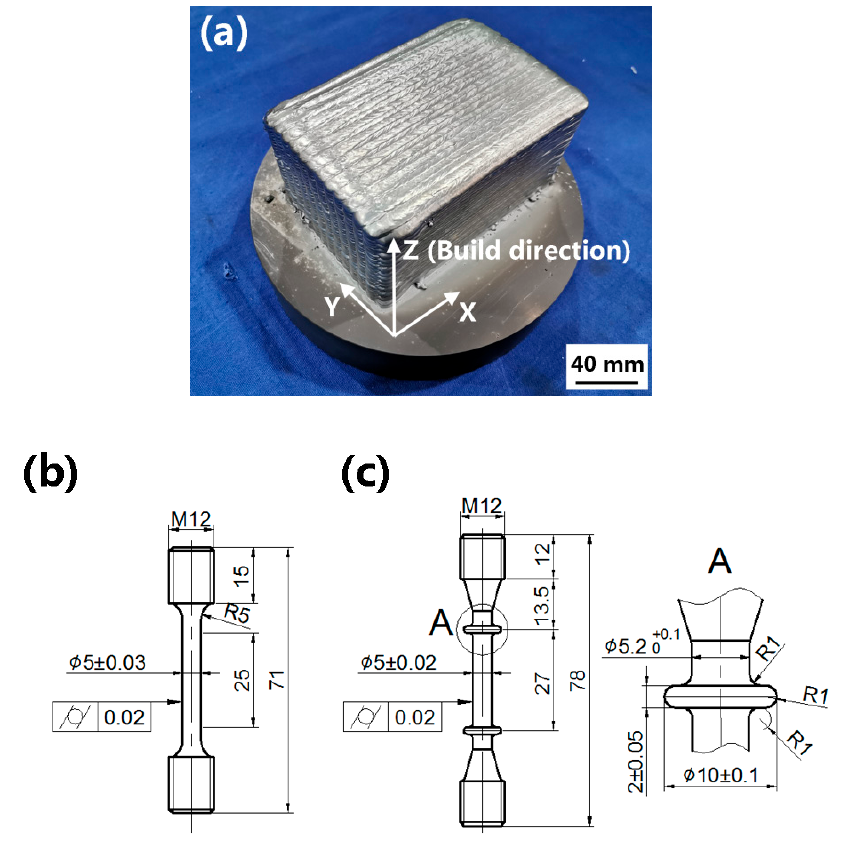
Figure 2. ( a ) EB-DED-formed sample, ( b ) tensile specimen, and ( c ) creep specimen.